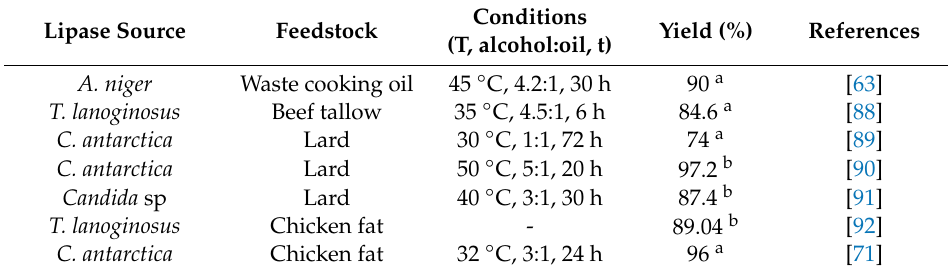
Table 2. Biodiesel production with various free soluble